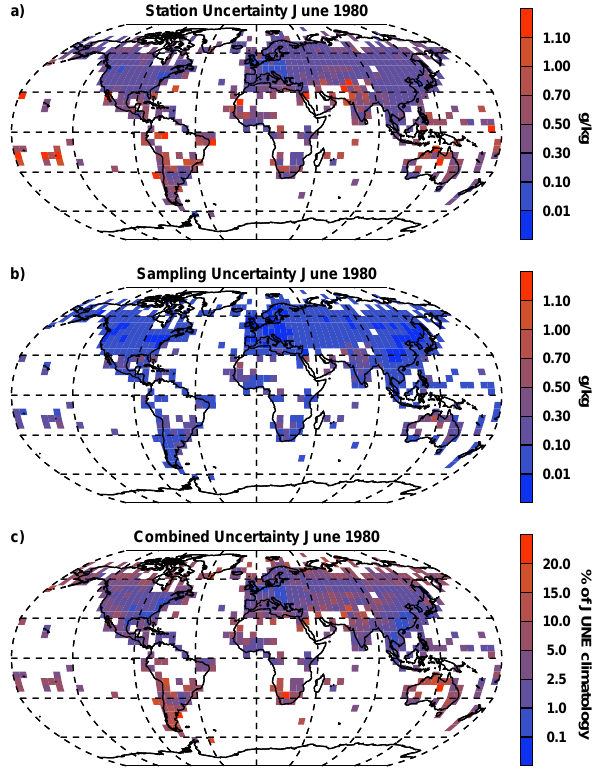
Fig. 8. Examples of gridded 2 σ uncertainty fields for HadISDH in June 1980 for (a) station uncertainty, (b) sampling uncertainty and (c) combined uncertainty as a percentage of the grid-box climato- logical (1976–2005) value for June. Note non-linear colour